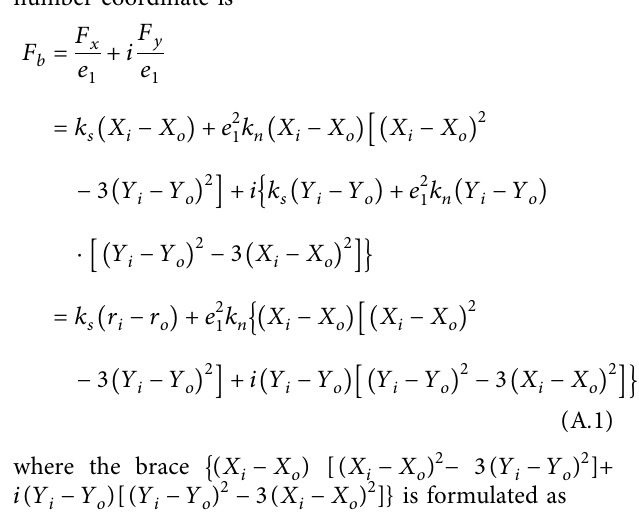
Figure 9: Amplitude frequency curves for the bifurcation mode of the hysteresis set curve H ( k n � 45 × 10 23 N/m 3 , k s � 10 × 10 8 N/m). (a) For the LP rotor. (b) For the HP rotor. Solid lines represent stable solutions, and dotted lines represent unstable